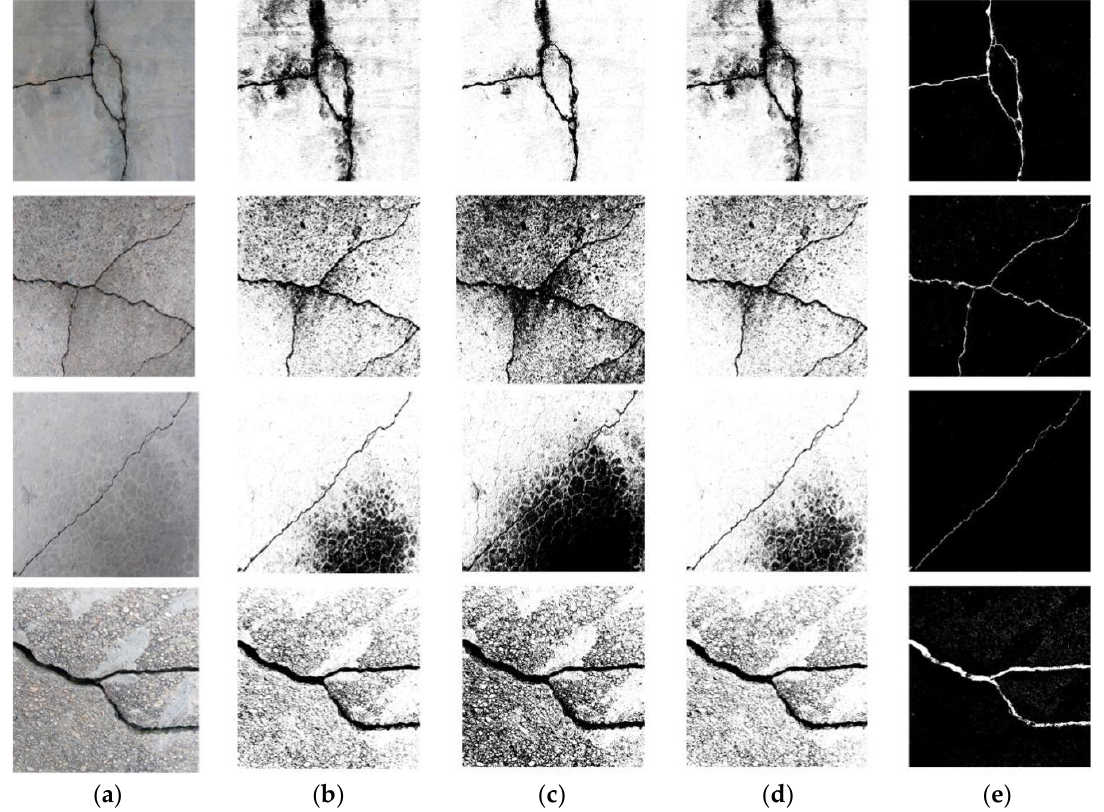
Figure 15. Comparison of crack feature extraction algorithms, subject to ( a ) no treatment; ( b ) linear enhancement filtering method; ( c ) iterative threshold segmentation method; ( d ) bit plane slicing; ( e ) MLP proposed in this paper.